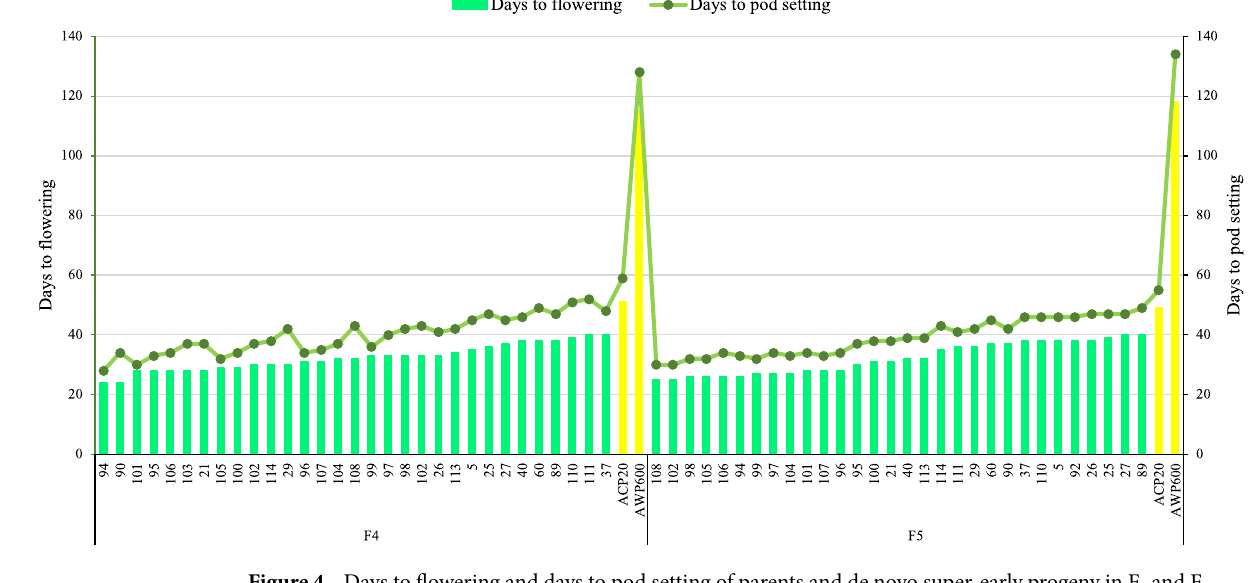
Figure 4. Days to flowering and days to pod setting of parents and de novo super-early progeny in F 4 and F 5 populations derived from interspecific crosses P. sativum × P. fulvum